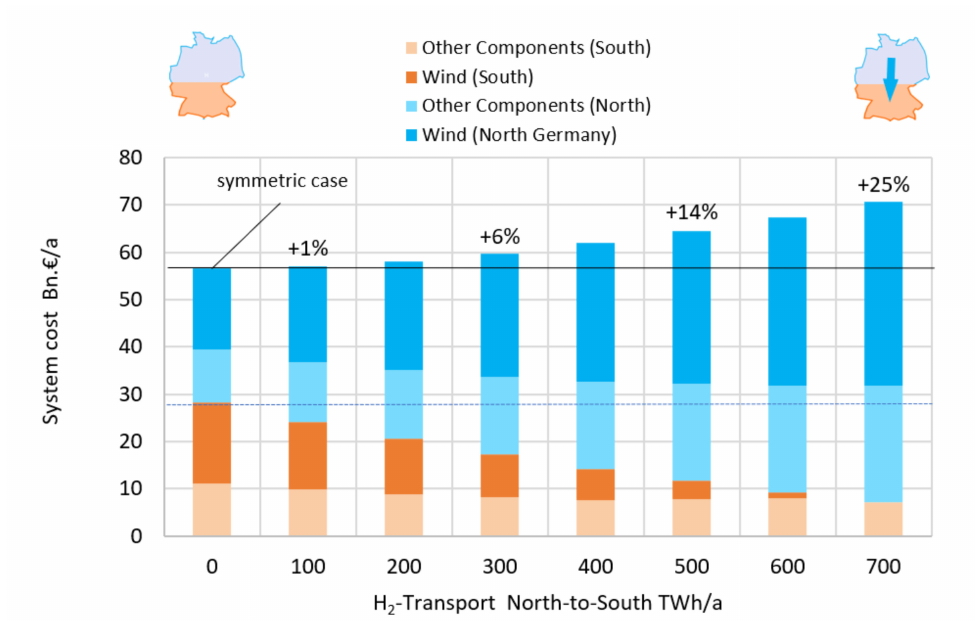
Figure 5. Cost structure of an electrically separated Germany versus varied hydrogen transport volumes from north to south.